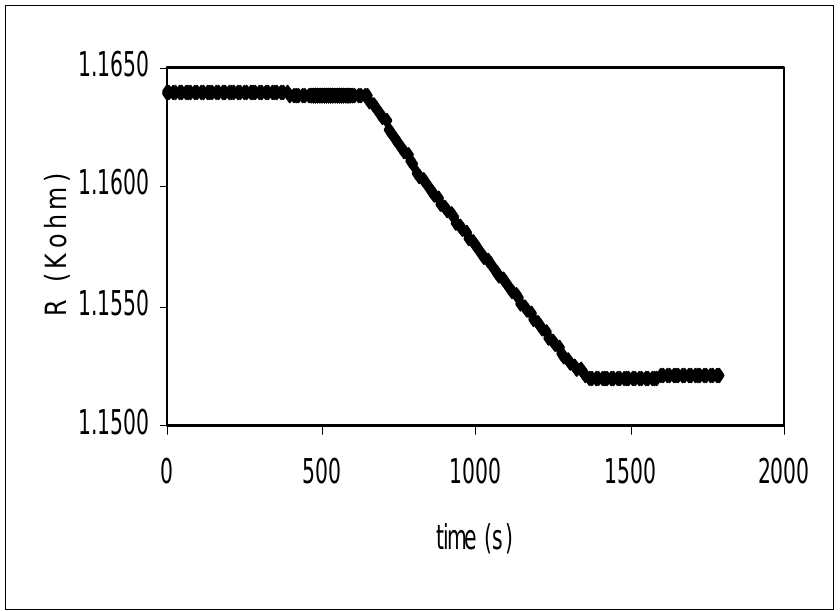
Figure 4. Determination of the Heat Capacity of the Cell-Water System at 25.0